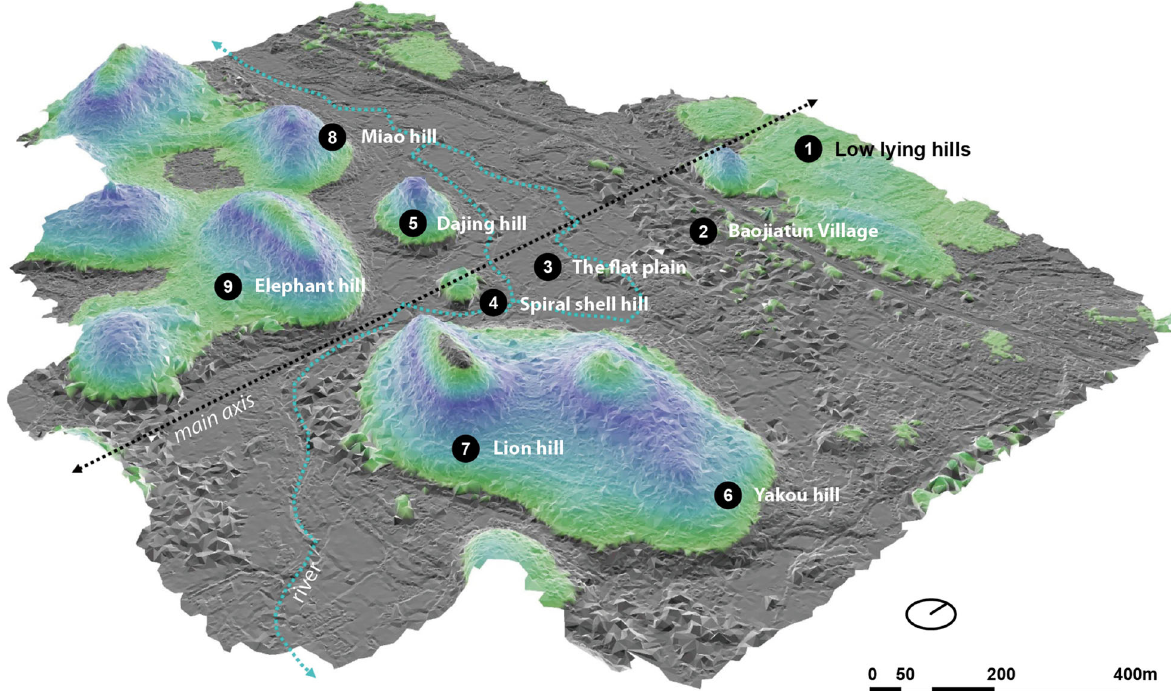
Fig. 5 Digital terrain model showing the geographical features of Baojiatun (Source: the